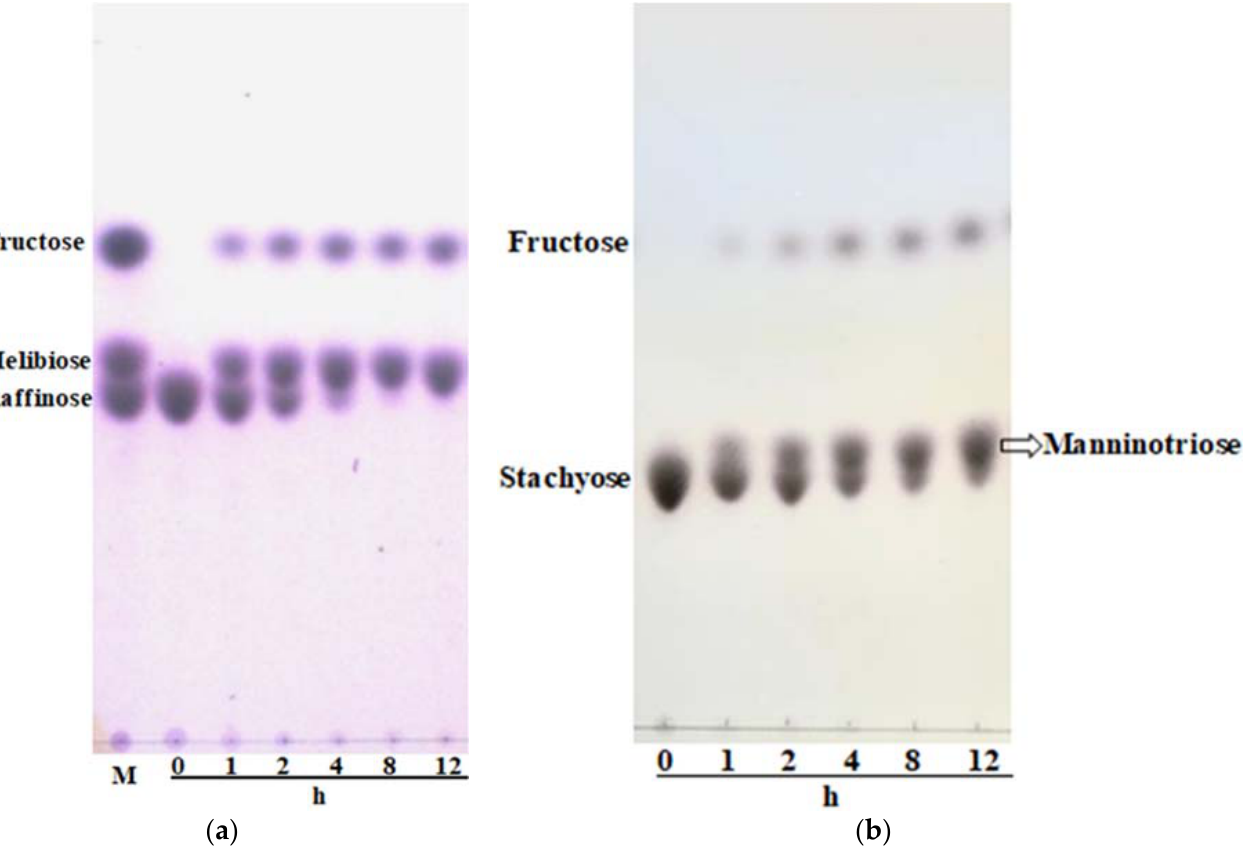
Figure 6. Hydrolysis of ra ffi nose ( a ) and stachyose( b ) by LcFFase1s. The reaction mixture containing 20 mg/mL of substrates in 50 mM sodium hydrogen phosphate–citrate bu ff er (pH 6.5) and LcF- 20 mg/mL of substrates in 50 mM sodium hydrogen phosphate–citrate buffer (pH 6.5) and LcFFase1s Fase1s (5 U/mL) was incubated at 40 °C. (5 U/mL) was incubated at 40 ◦